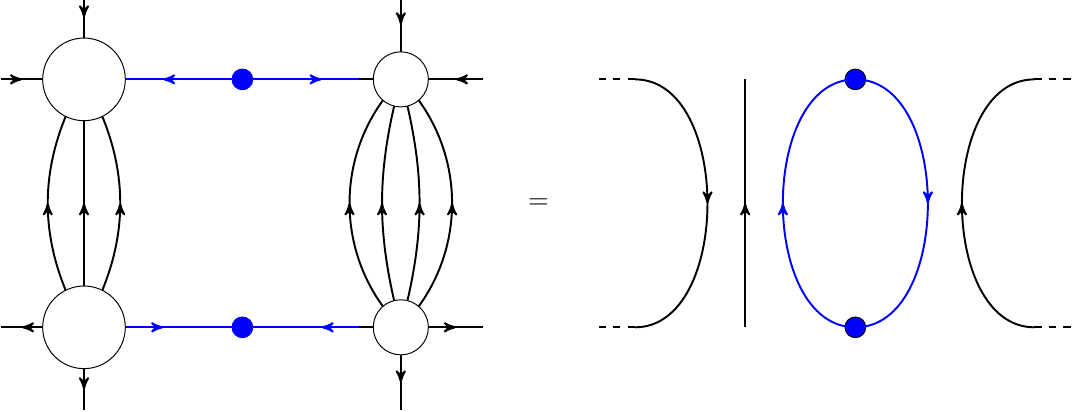
Figure 9. The basic simplification used to compute the density matrix of region A in figure 8b. The six leg tensors are from the edge of the network shown in figure 8b. The effect of the state given in equation (3.11) is to add a normalization factor, represented as the blue loop at right. The modified network is shown in figure 8b. We claim that this network satisfies the RT formula using our new definition of length in terms of mutual information, but not using the graph length. To see this we begin by computing the entropy of the three boundary legs marked region